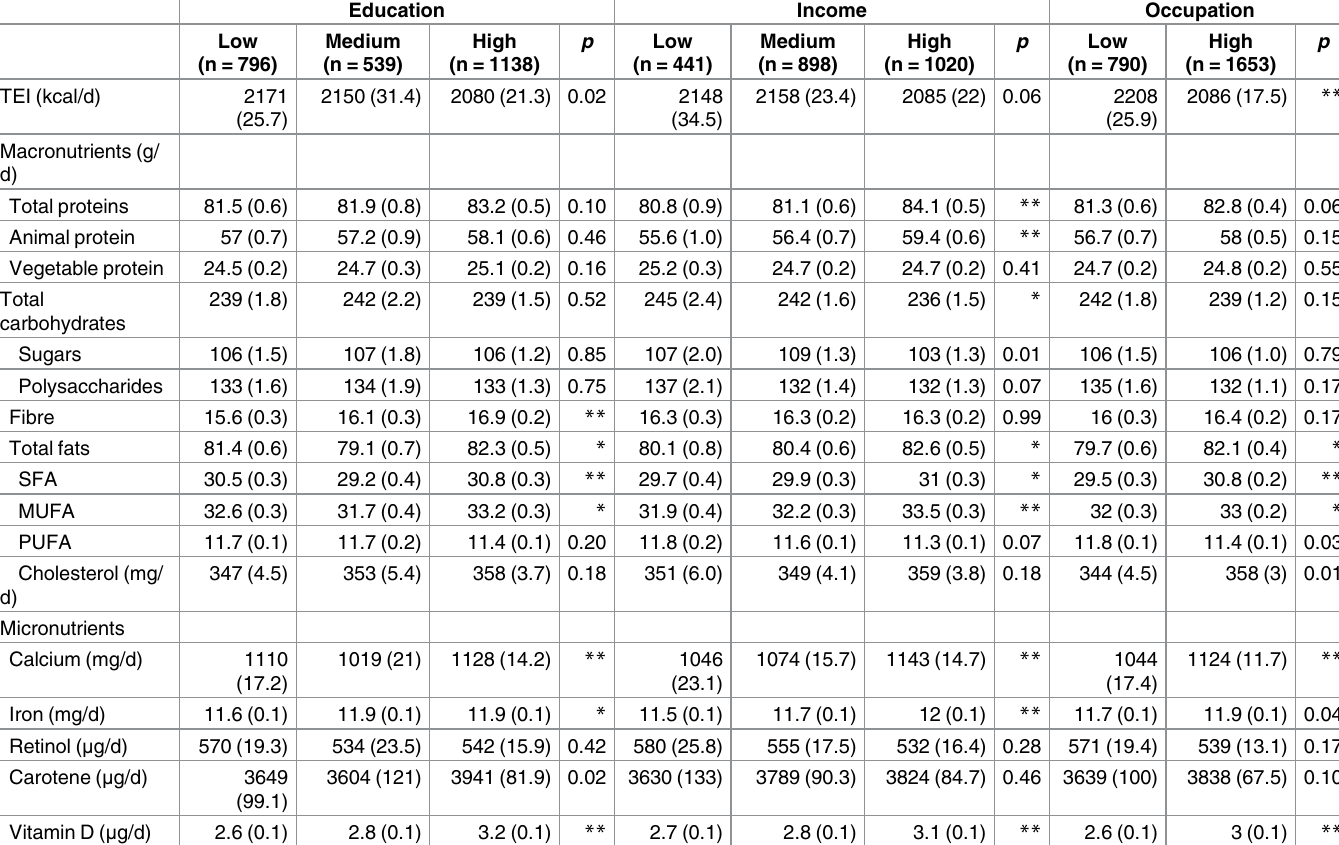
Table 2. Energy and nutrient intake (mean & SE) among men from “Bus Sante´” study, Geneva, Switzerland, years2005–2012,by socioeconomic status indicator, adjusted for age and